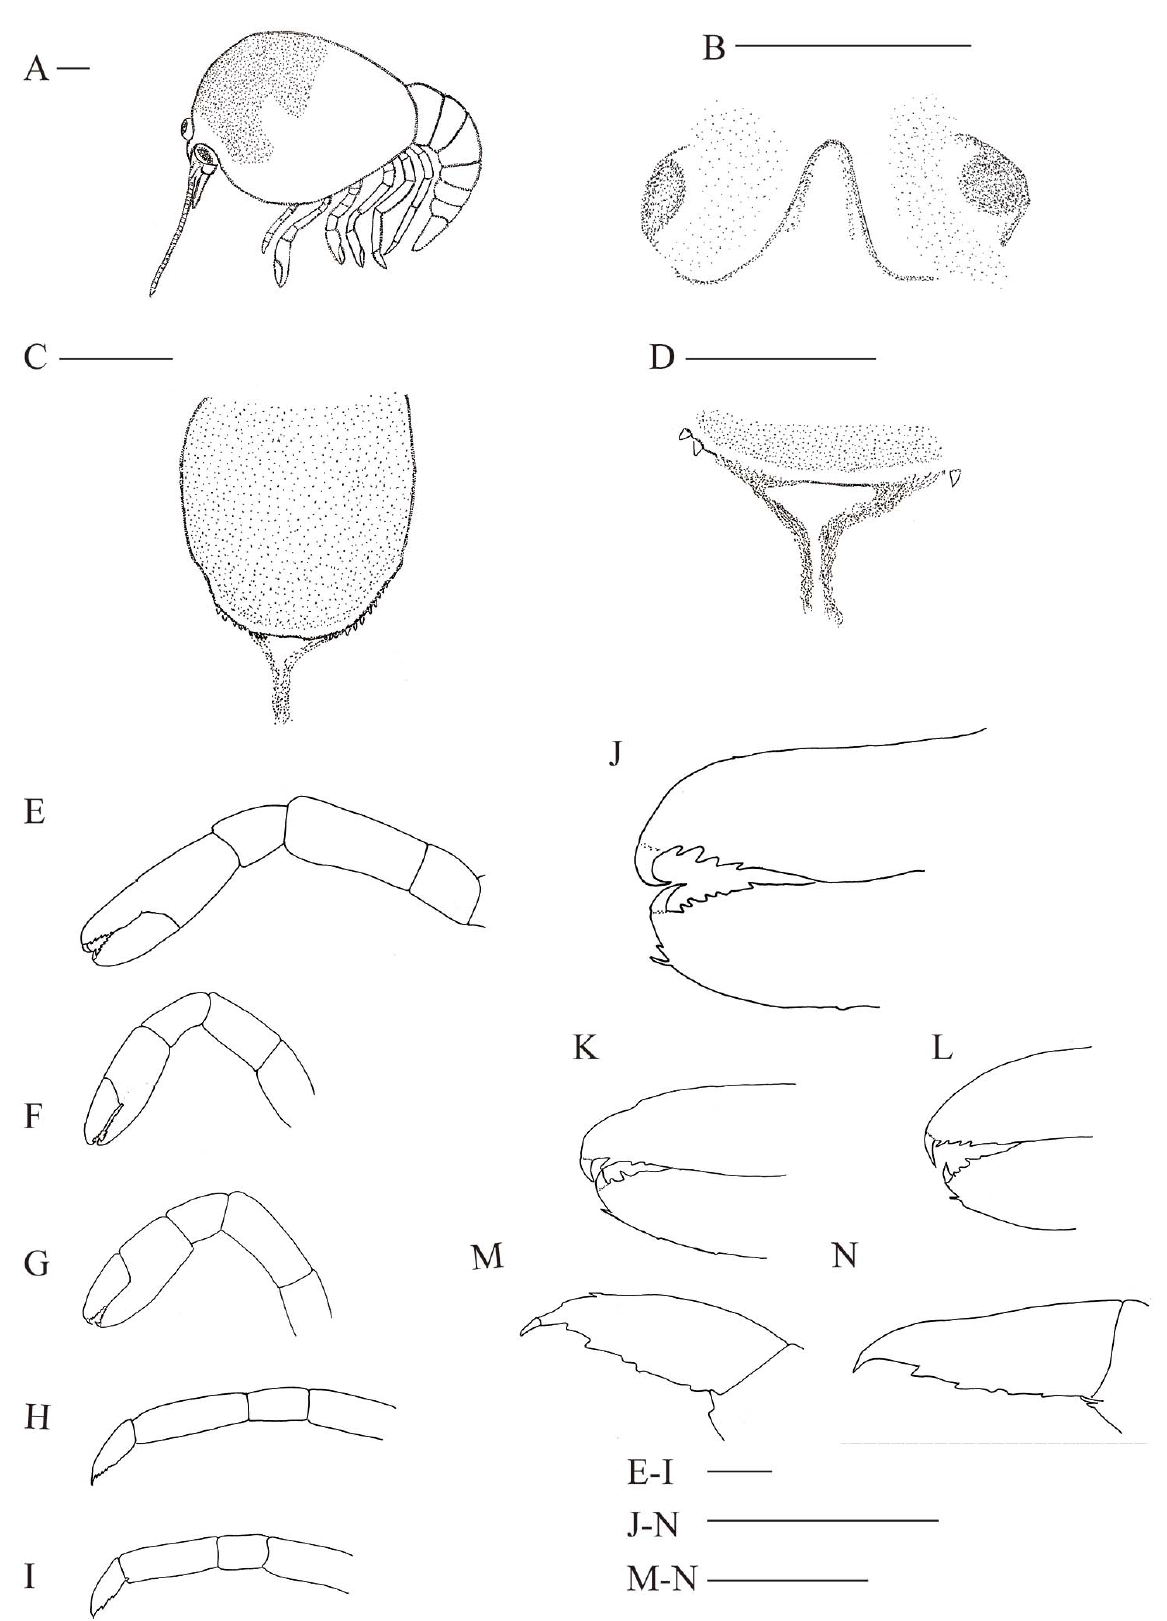
Figure 7. Juvenile Stage I of Procambarus virginalis . ( A ) Habitus, lateral view; ( B ) eyes and rostrum, dorsal view; ( C ) tail fan and telson thread, dorsal view; ( D ) posterior edge of the tail fan and telson thread; ( E–I ), pereiopods 1–5, dorsal or lateral view; ( J–N ) distal segments of pereiopods 1–5, dorsal or lateral view. Scale bars: 0.25